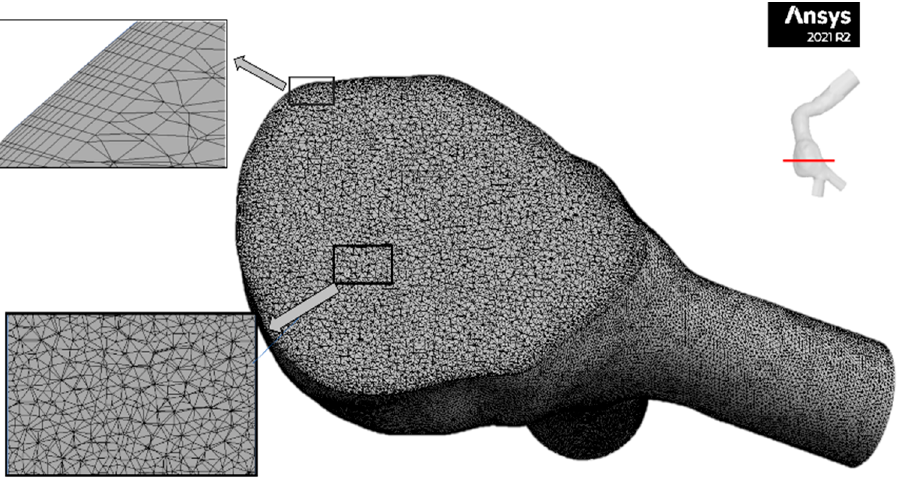
Figure 3. Mesh cross section through the aneurysm in the central region and enlarged view near the wall highlighting the local refinement.